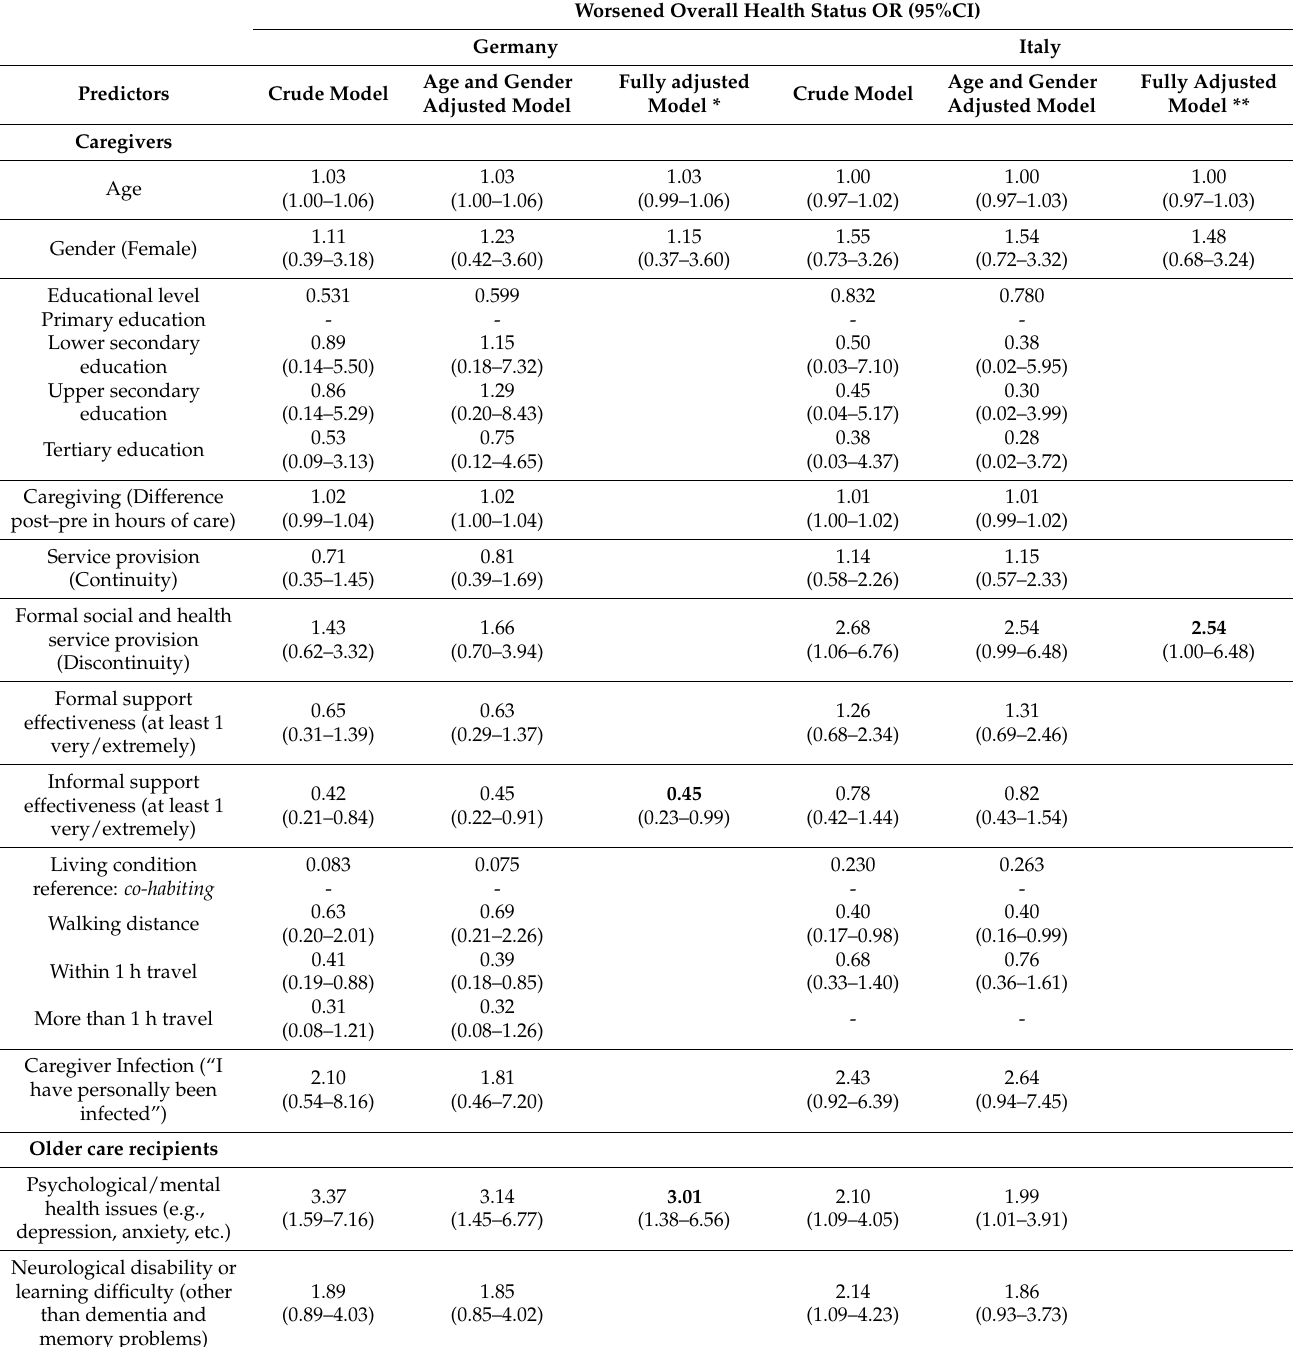
Table 6. Predictors of informal caregivers’ overall health status worsening by